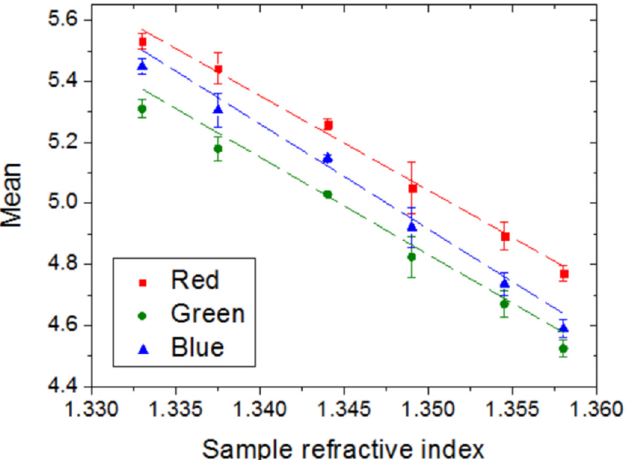
Figure 7. Mean value for red (red square dots), green (green circular dots), and blue (blue triangular dots) channels of the diffraction images as a function of the sample refractive index.